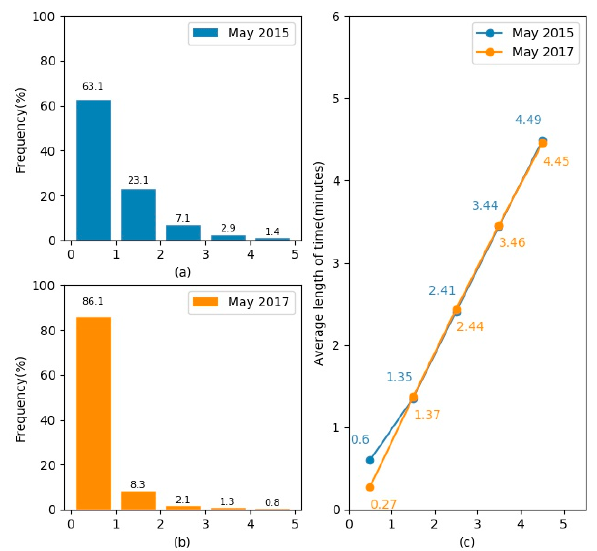
Figure 10. Duration of payment. ( a ) Distribution of payment durations within 5 min in May 2015; ( b ) distribution of payment durations within 5 min in May 2017; ( c ) the average payment time in each bar.